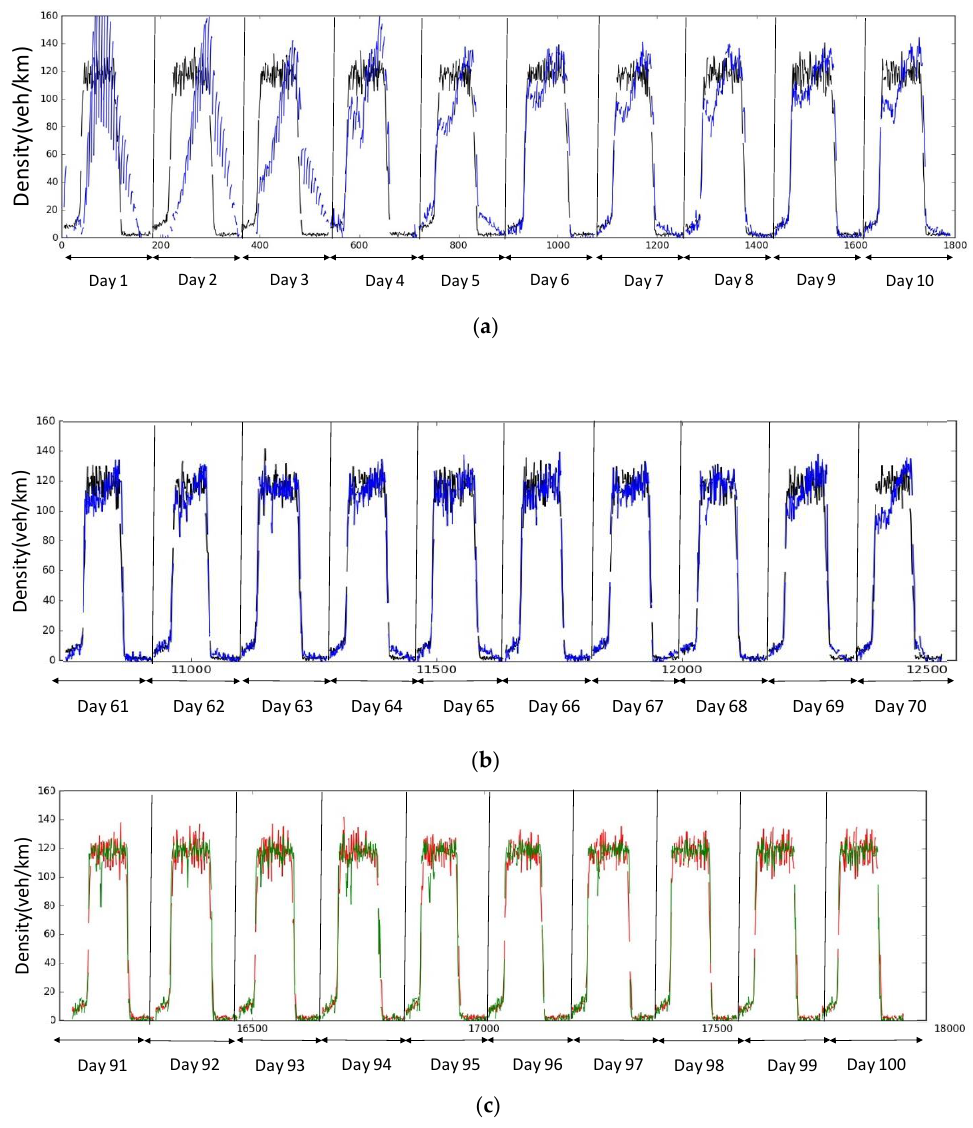
Figure 7. Training Process and the evaluation with the test data set. ( a ) Training Process for day 1 to 10 (link 13); ( b ) Training process for day 61 to 70 (link 13); ( c ) Test results for day 91 to 100 (link 13).